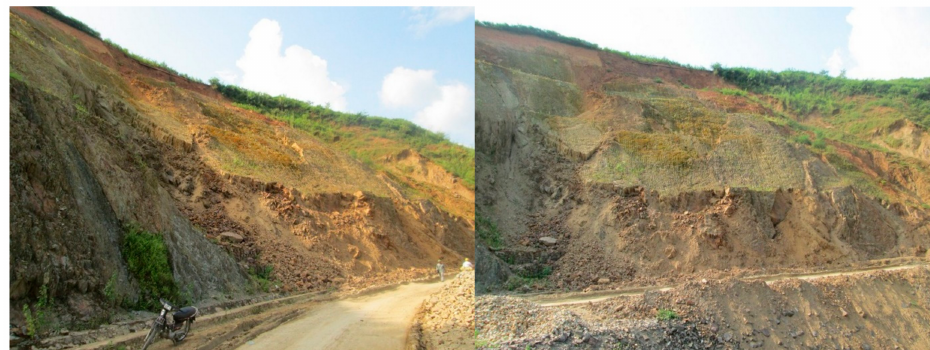
Figure 2. Two photos of the landslide on the slope wall of National Road 279, near the right bank of Nam Kim stream, Na Pa village, Muong Kim commune, Than Uyen district. Source: Vietnam Institute of Geosciences and Mineral